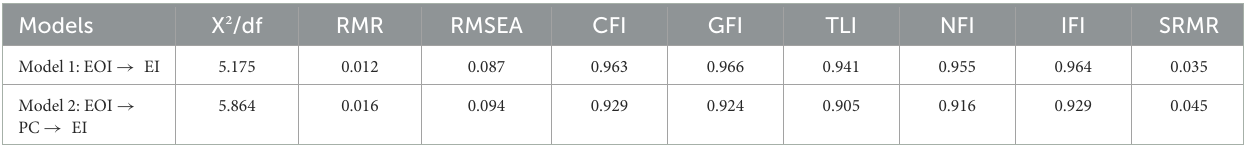
TABLE 6 Structural model validity.